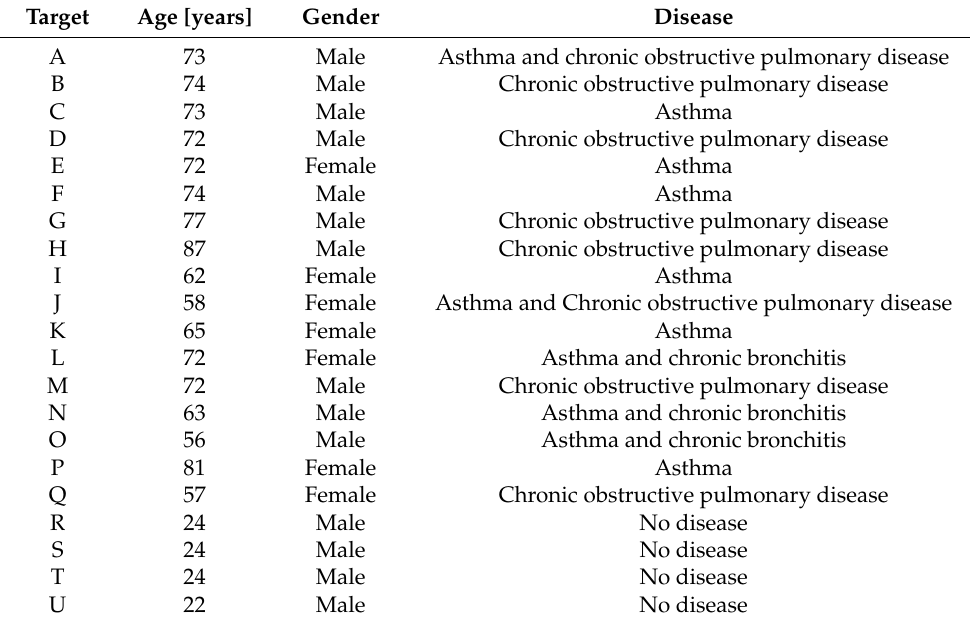
Table 2. Characteristics of subjects.